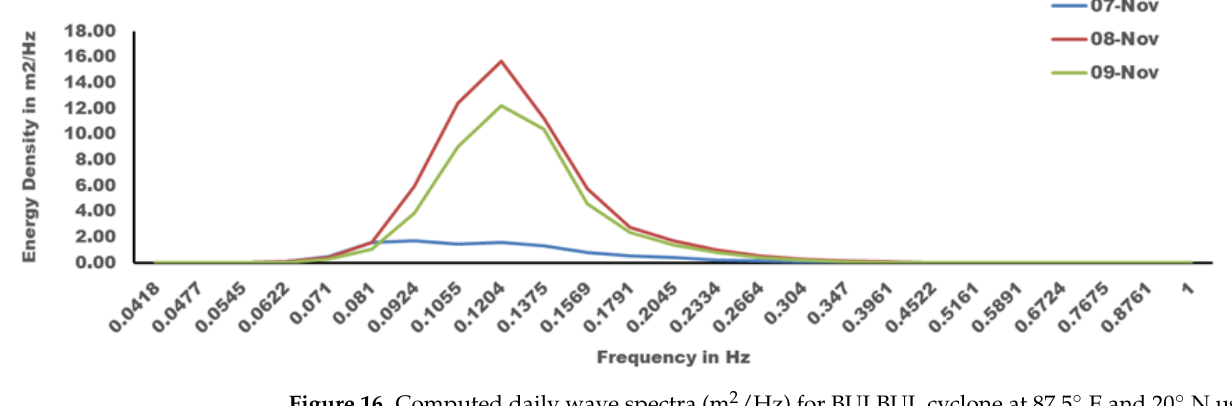
Figure 16. Computed daily wave spectra (m 2 /Hz) for BULBUL cyclone at 87.5° E and 20° N using SCATSAT − 1 daily 25 km wind data.